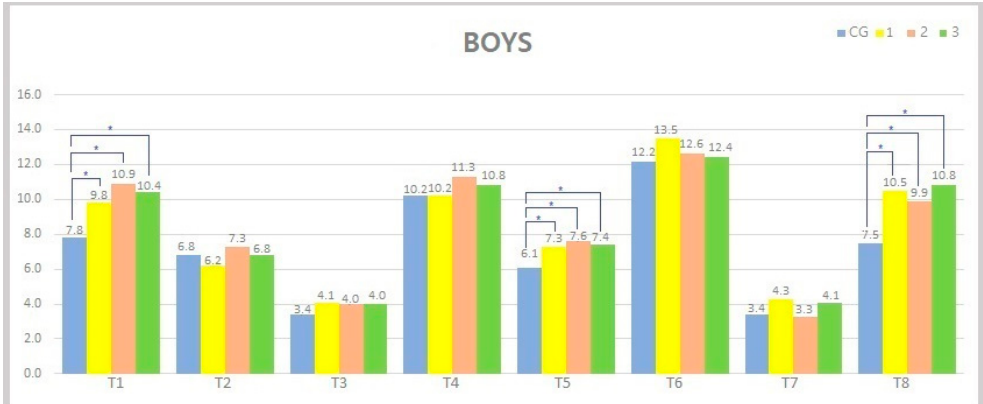
Figure 3. Presentation of variables and mean values within individual groups in boys (CG—control group, EG—experimental groups, G1—120 h of exercise, G2—350 h of exercise, G3—470 h of exercise). (T1—motor precision, T2—motor integration, T3—ambidexterity, T4—hand coordination, T5—balance, T6—bilateral coordination, T7—speed and agility, T8—strength); * represents a statistically significant difference between the groups ( p < 0.05).